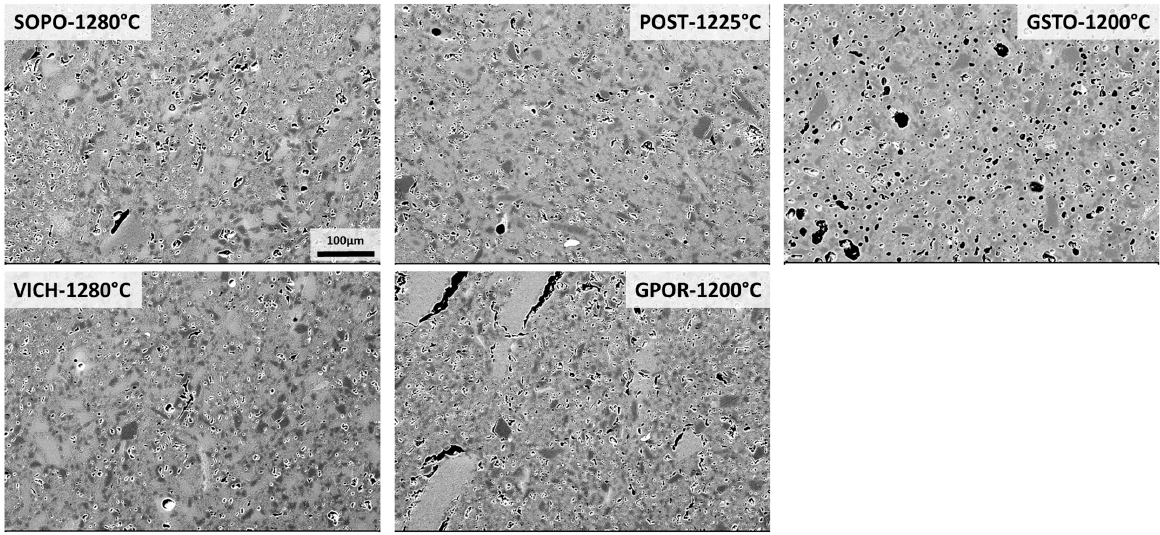
Figure 6. SEM micrographs of bodies at the optimal firing temperature (scale bar = 100 µm).